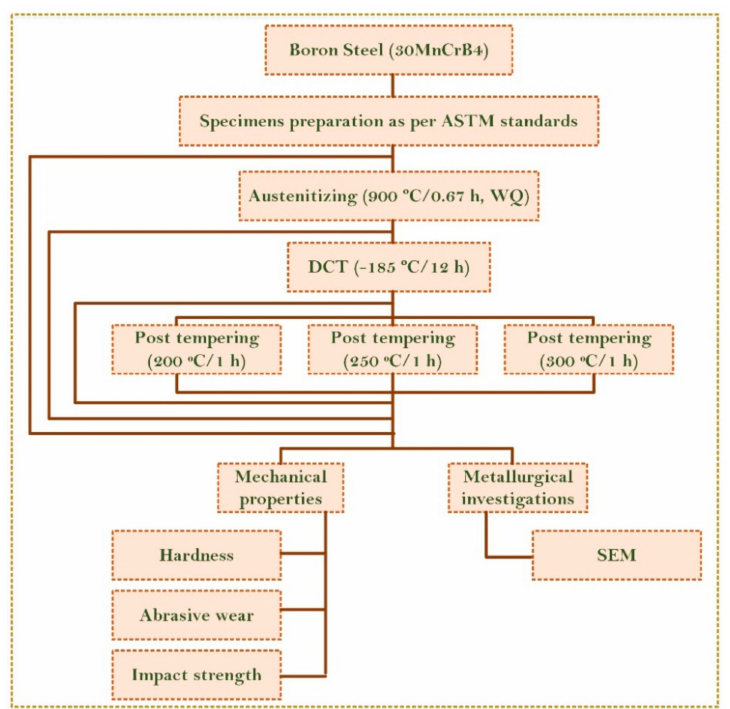
Figure 1. Schematic plan of thermal treatments and di ff erent investigations.